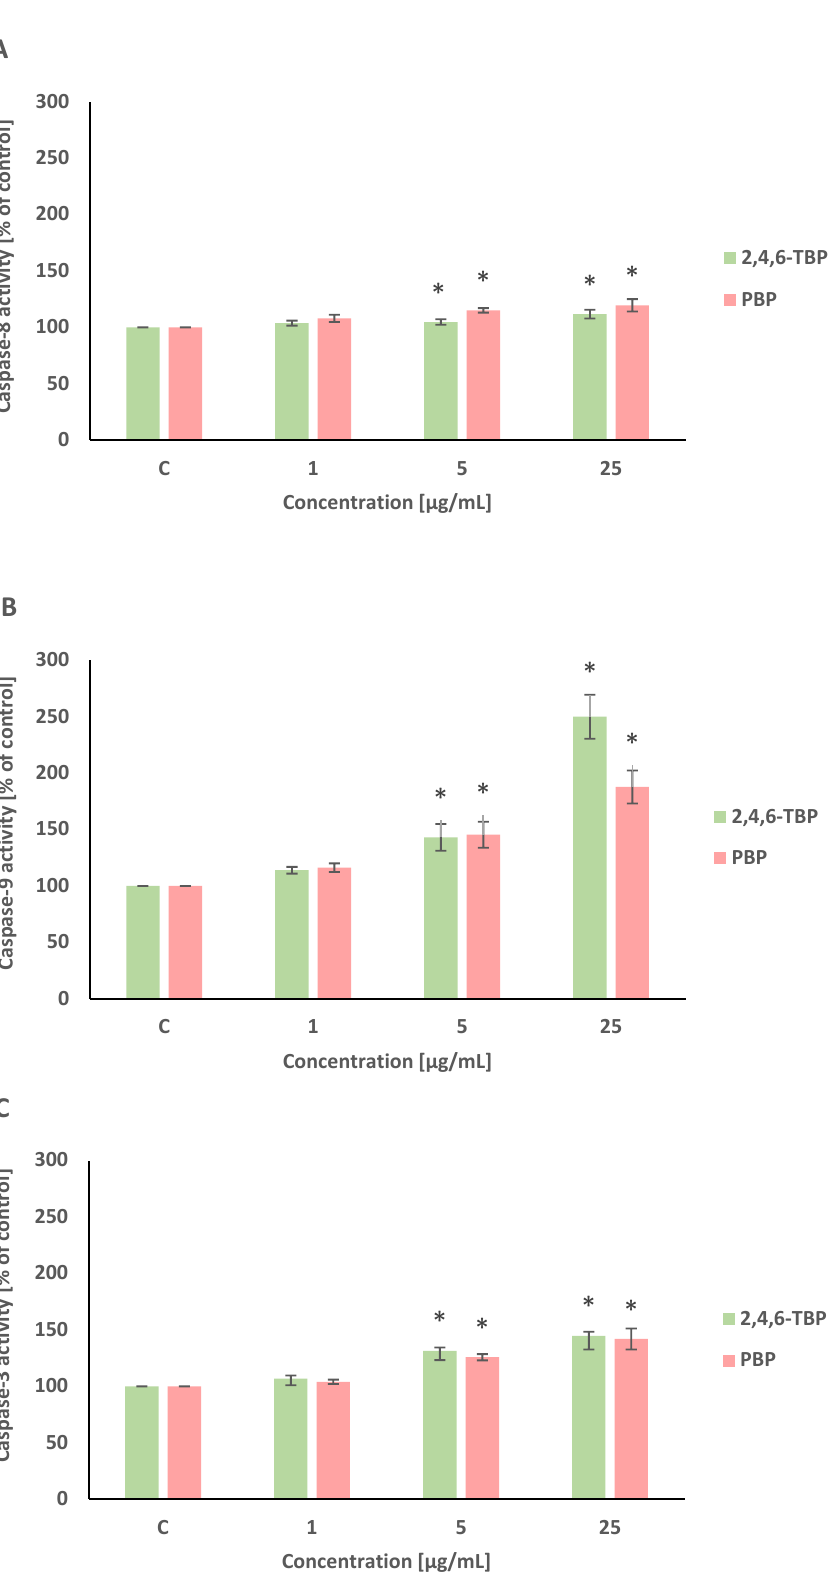
6 of 18 calculated from four individual experiments (four blood donors). Results were statistically different from negative control at * p < 0.05. Statistical analysis was conducted using one-way ANOVA and a posteriori Tukey test. 2.4. Caspase-8, -9, and -3 Activation